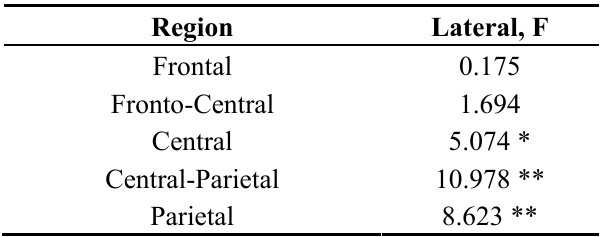
Table 5. Delay conditions only. Follow up analysis of the order × anteriority effect, 600–900 ms from the onset of the pre-delay letter at lateral sites. F -values for the effect of order are given for each anteriority